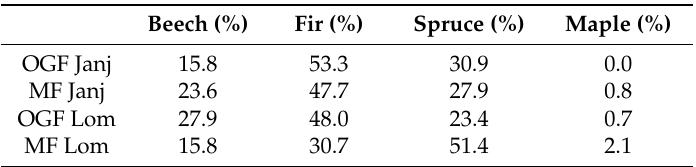
Table 1. Tree species composition by volume of live trees in old-growth forests (OGFs) and managed forests (MFs) in the study area. Beech (%) Fir (%) Spruce (%) Maple